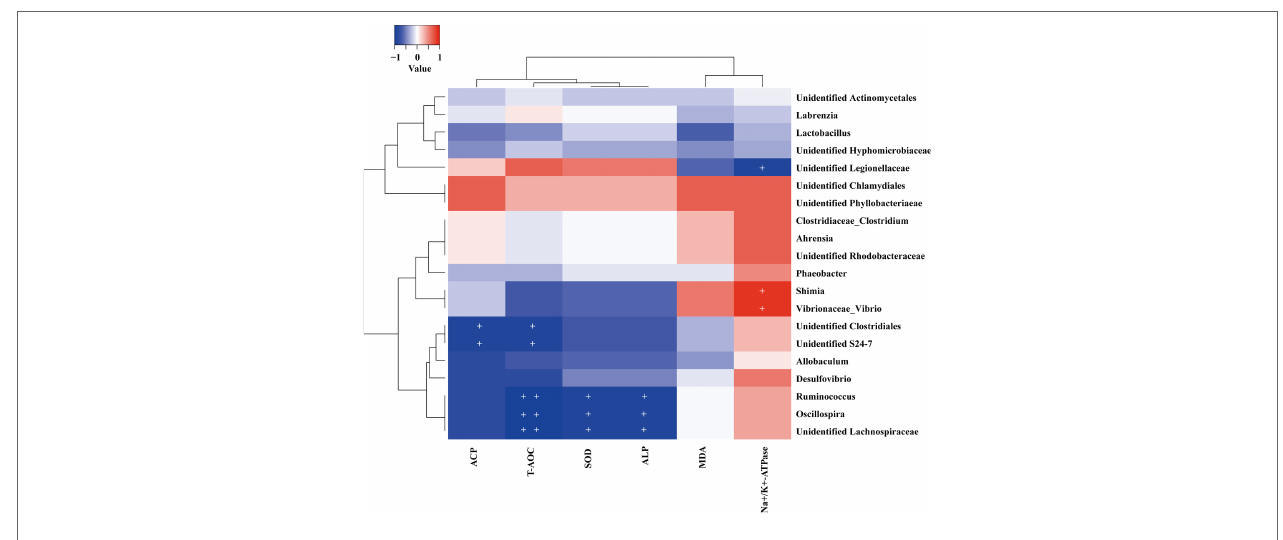
FIGURE 7 | Heat map showing Spearman correlation between the abundance of the top 20 genus intestinal bacteria and the physiological characteristics in the U. unicinctus juveniles. + indicates that P < 0.05 and ++ indicates that P <